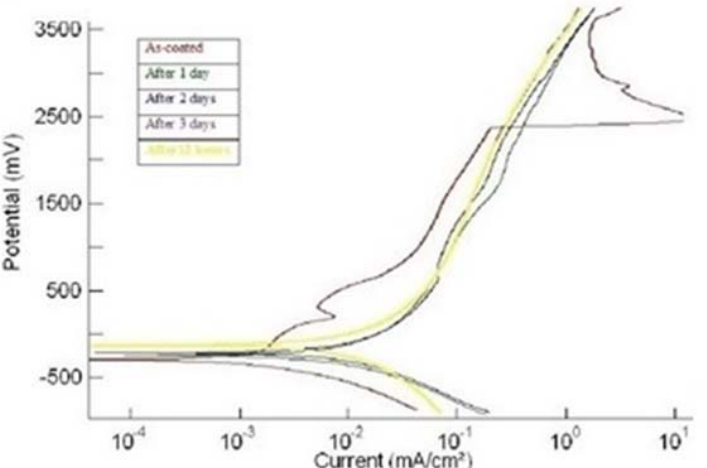
Figure 1. Polarization curves of ‘1us’.